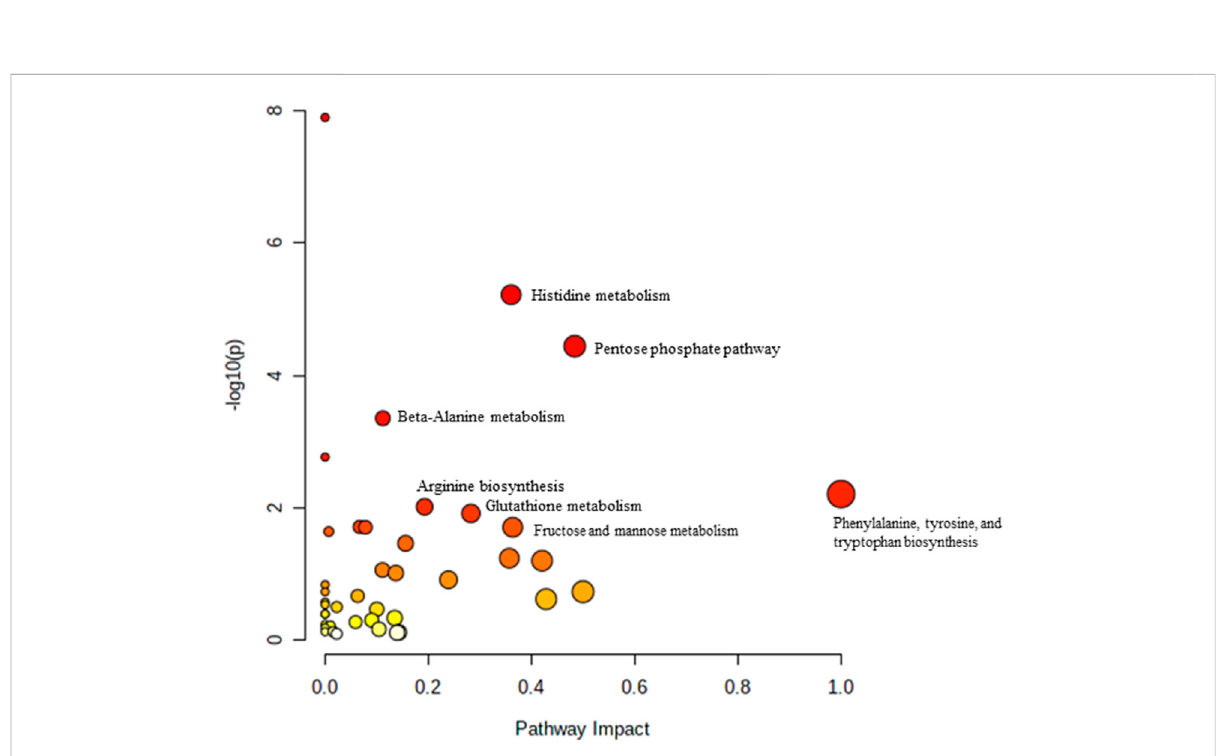
FIGURE 3 Biochemical pathway analysis of metabolites pro fi led for YC vs.